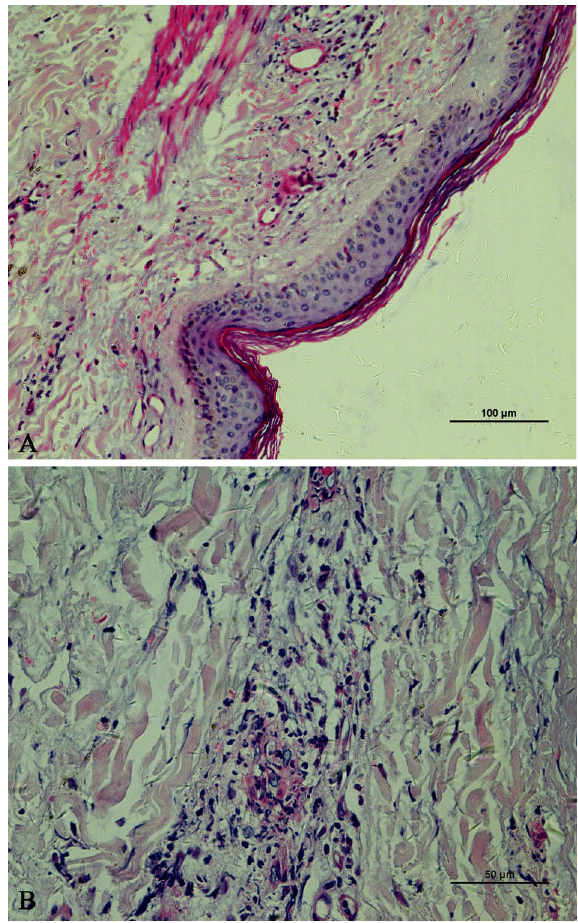
Figure 2. Hematoxylin and eosin stain showing chronic in fl am- matory cell in fi ltration around small blood vessels ( A , (cid:1) 200) and fi brous connective tissue hyperplasia ( B , (cid:1) 400). Scale bars: 100 m m ( A ) and 50 m m ( B ).